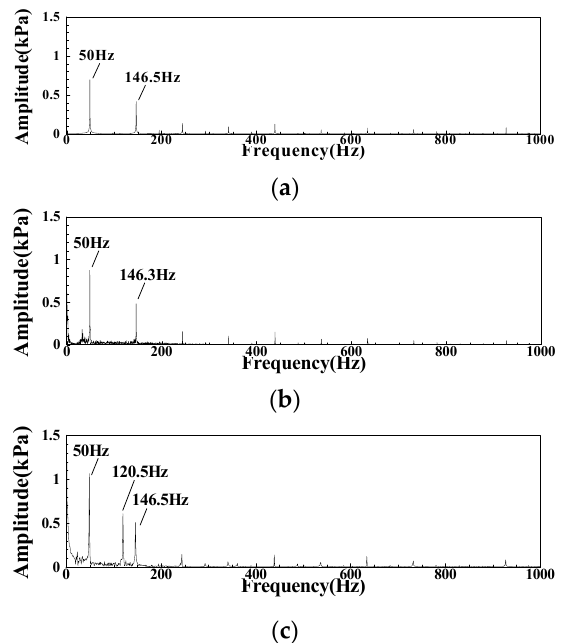
Figure 15. The spectrum of fuel pressure signals under different operating conditions: ( a ) LA01; ( b ) LA02; ( c ) LA03.